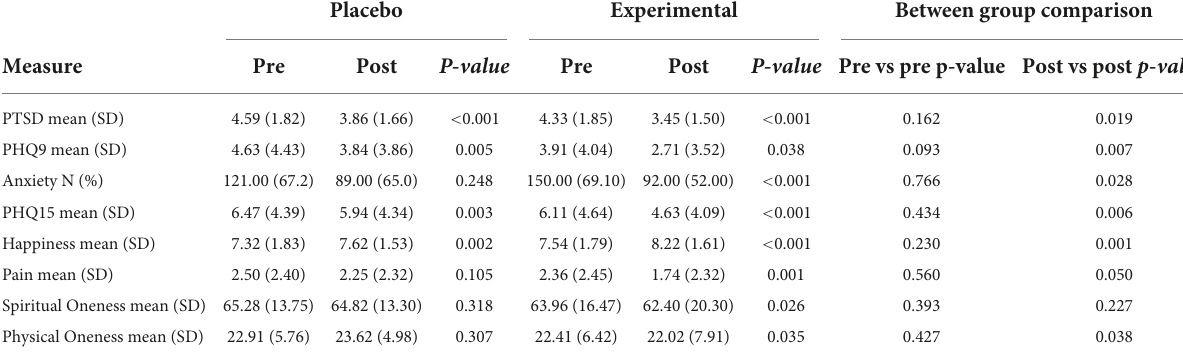
TABLE 1 Pre- and post-test psychological measures ( N = 513). Placebo Experimental Between group comparison